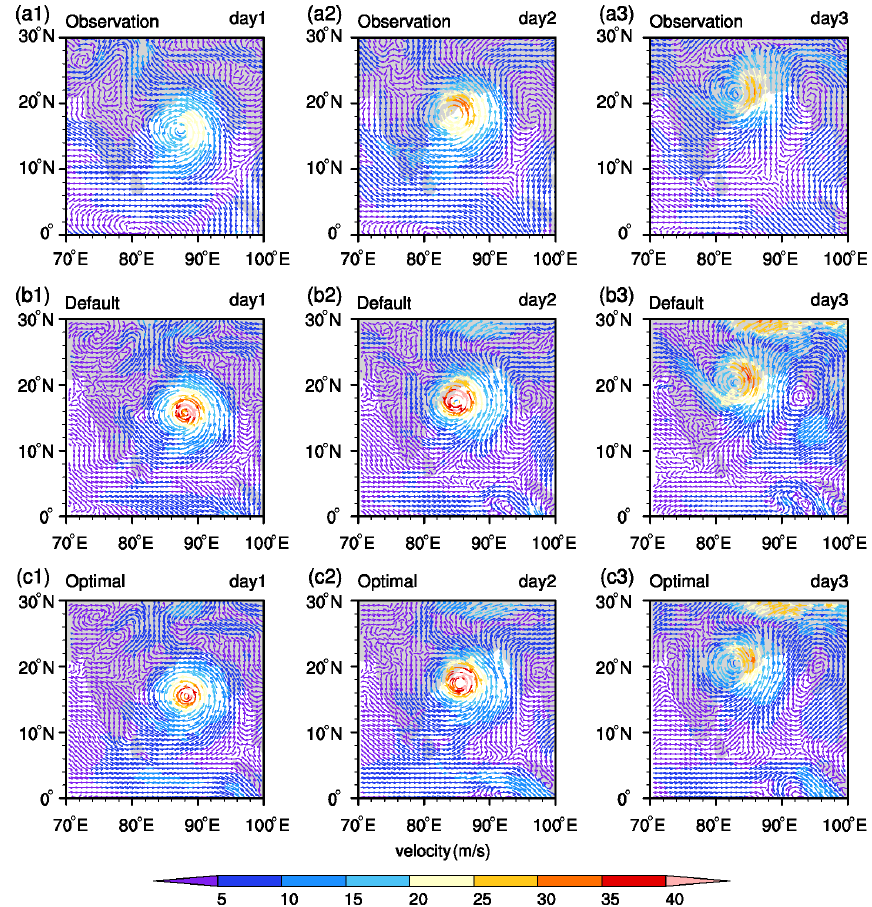
Figure 17. Same as Fig. 16 but for VSCS